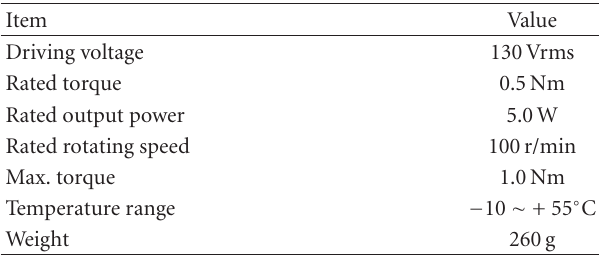
Table 1: Specification of USR60